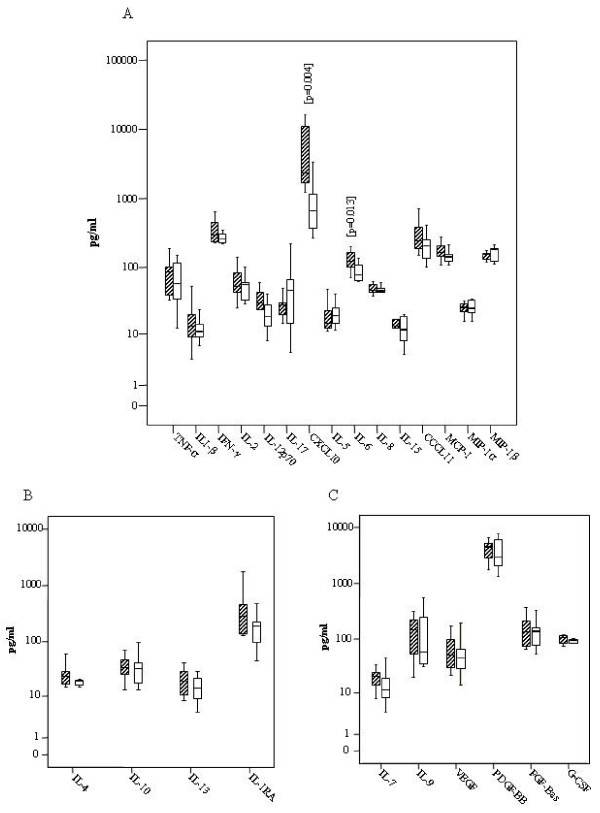
Distribution of cytokines among Type 1 reaction leprosy patients (traced boxes) and controls without reaction (white boxes). (A) Pro inflammatory Cytokines, CXCL10 and IL-6 median values were statistically higher for TR1 than controls (B) Anti Inflammatory cytokines (C) Growth Factors. Boxes encompass 25th and 75th percentiles of each cytokine distribution. Black lines within boxes refer to the median values.